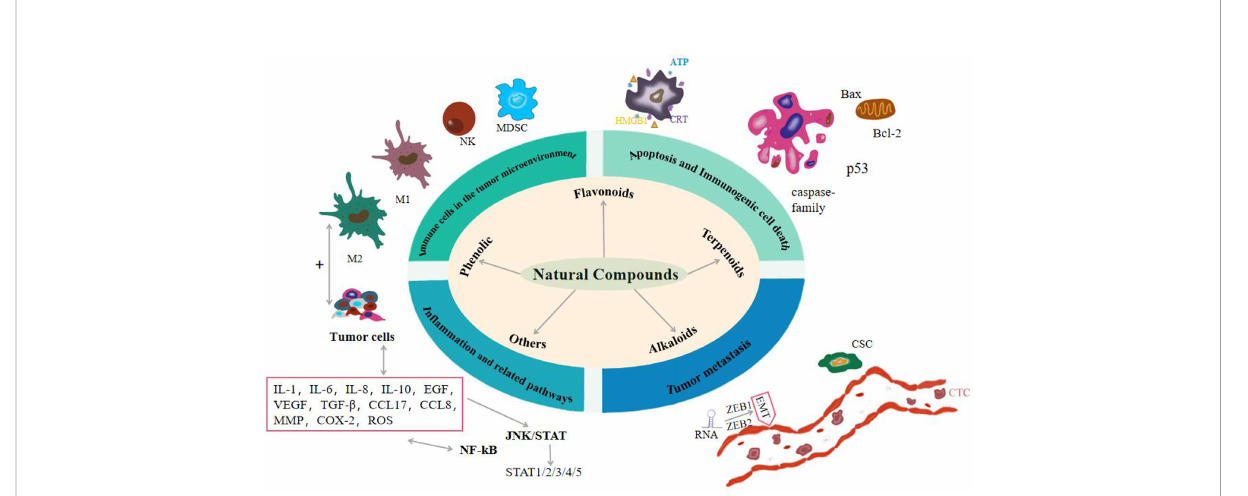
FIGURE 1 Effects of natural compounds on cancer from four aspects: apoptosis and immunogenic cell death, immune cells in the tumor microenvironment, in fl ammation and related pathways, and tumor